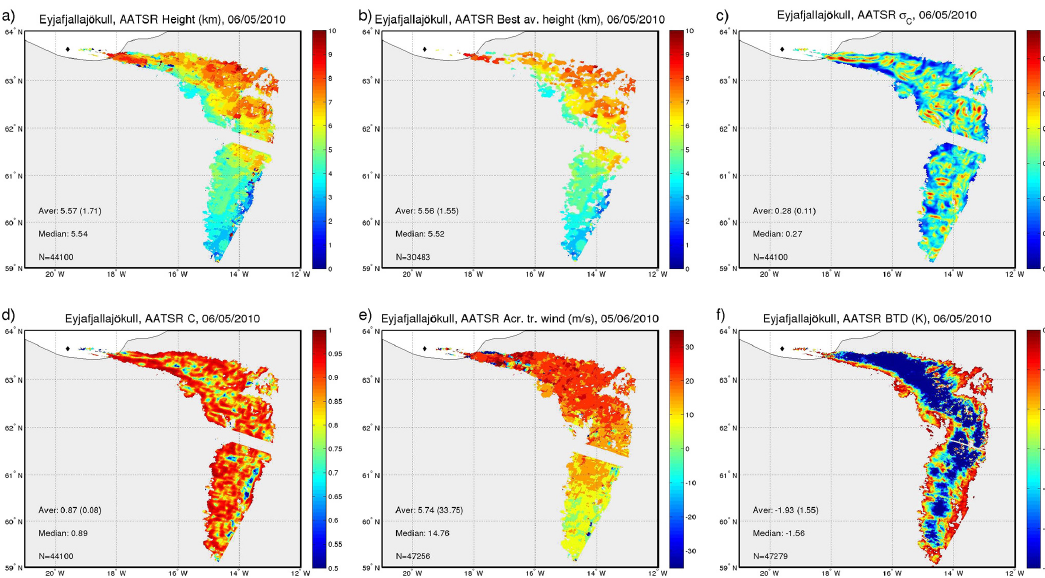
Figure 16. Example case of 6 May 2010 over Iceland. (a) Single-pixel height estimate; (b) best-average-height estimate; (c) standard deviation of C within the correlation matrix; (d) the cross-correlation coefficient C ; (e) the across-track wind speed (ms − 1 ); (f) the brightness temperature difference BTD (scale limited to − 3K). The text inserts on the lower left-hand corners of the images show the average value (standard deviation) and median of each quantity and the number of pixels used. See text for